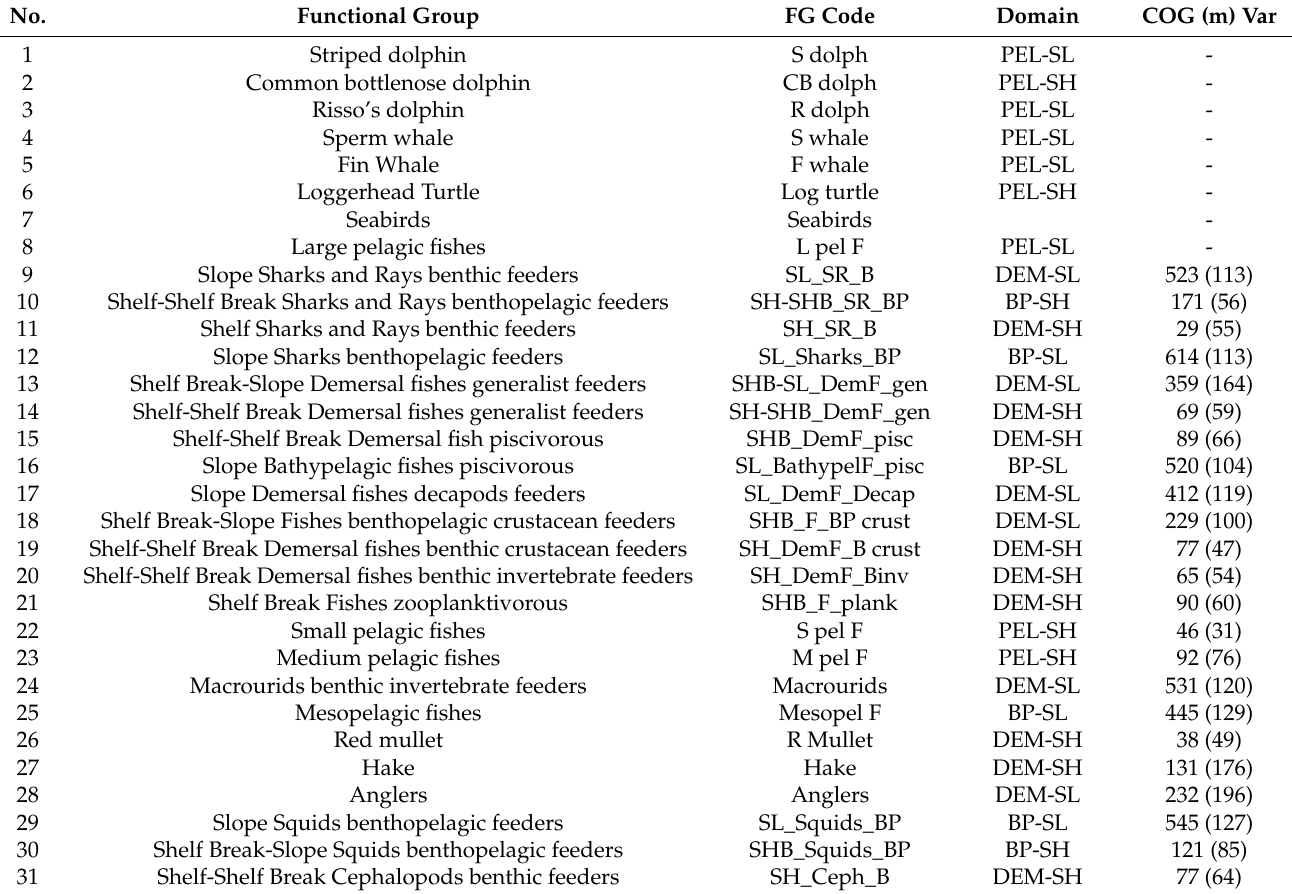
Table 2. Functional groups with codes and the relative domains in the Gulf of Taranto food web model. Domains are coded as Planktonic (Plank), Benthic (BENT), Pelagic groups of shelf (PEL-SH), Pelagic groups of slope (PEL-SL), Demersal groups of shelf (DEM-SH), Demersal groups of slope (DEM-SL), Benthopelagic groups of Shelf (BP-SH), Benthopelagic groups of Slope (BP-SL). The centre of gravity (COG, m) and variance (Var) in meters are reported when available.